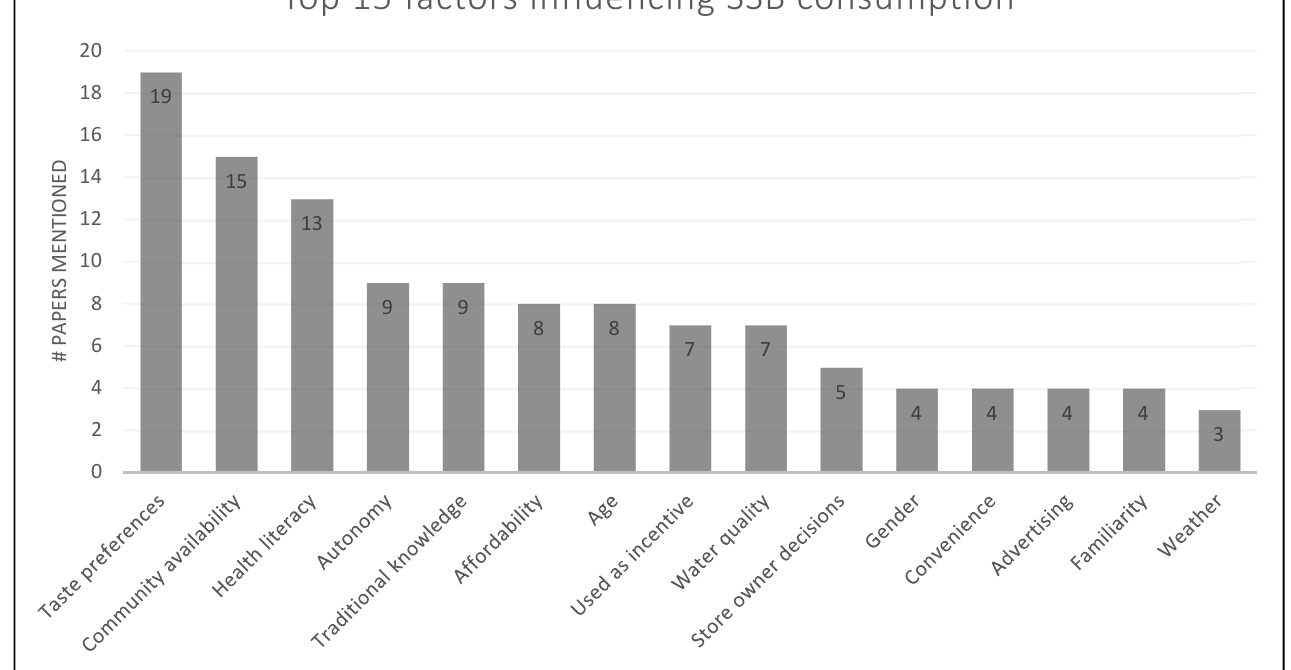
Figure 2. Factors reported to influence SSB consumption in 3 or more of the included studies.